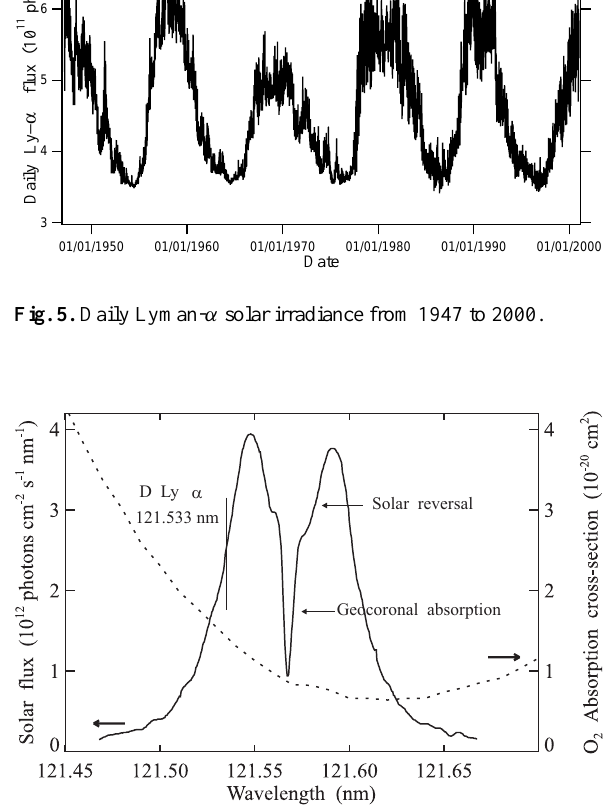
Fig. 6. Lyman- α profile (Lemaire et al., 1978) and O 2 absorption cross Sect. (Lewis et al., 1983) for 203